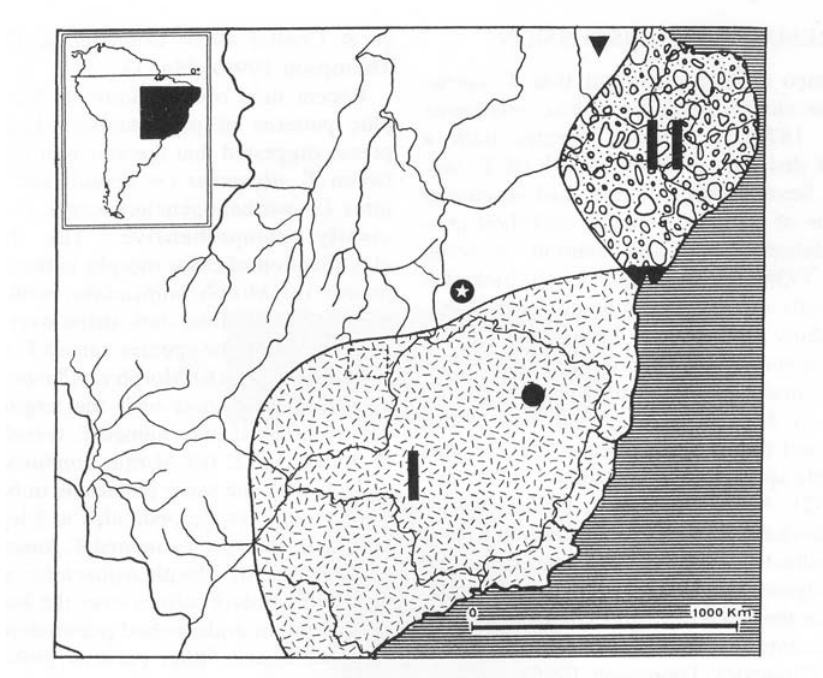
Figure 16. Geographical distribution of Tityus serrulatus (zone I) and possible location of the sexual population in the north of Minas Gerais State (black